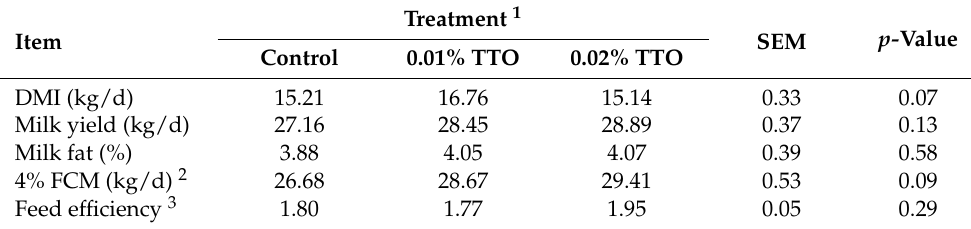
Table 2. Effects of TTO on production performance in postpartum dairy cows.